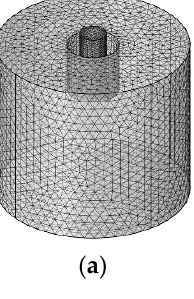
Figure 8. The meshed model for HRs with aperture for various tangent sectional shapes. ( a ) Round; ( b ) regular triangle; ( c ) square; ( d ) regular pentagon; and ( e ) regular hexagon.